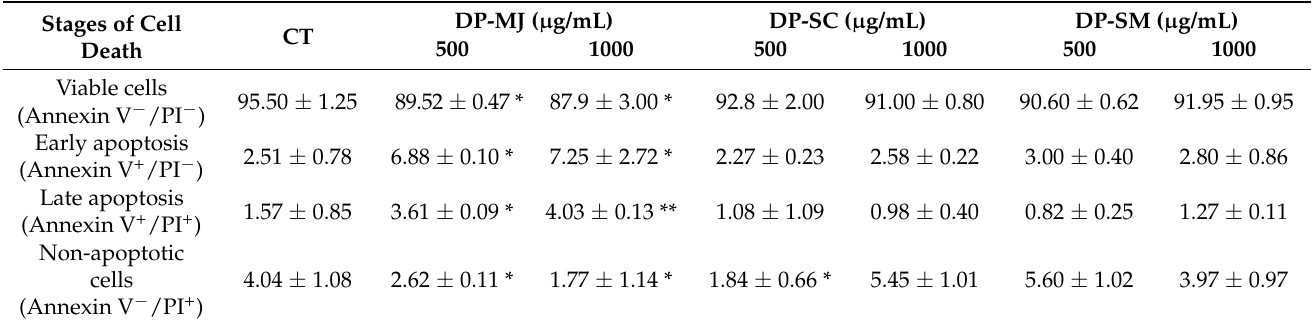
Table 5. Effect of extracts of dried peel powders (DP) extracts of M. jaboticaba (DP-MJ), S. cumini (DP-SC), and S. malaccense (DP-SM) (500–1000 µ g/mL) on programmed cell death in adenocarcinoma cell line after 24 h.